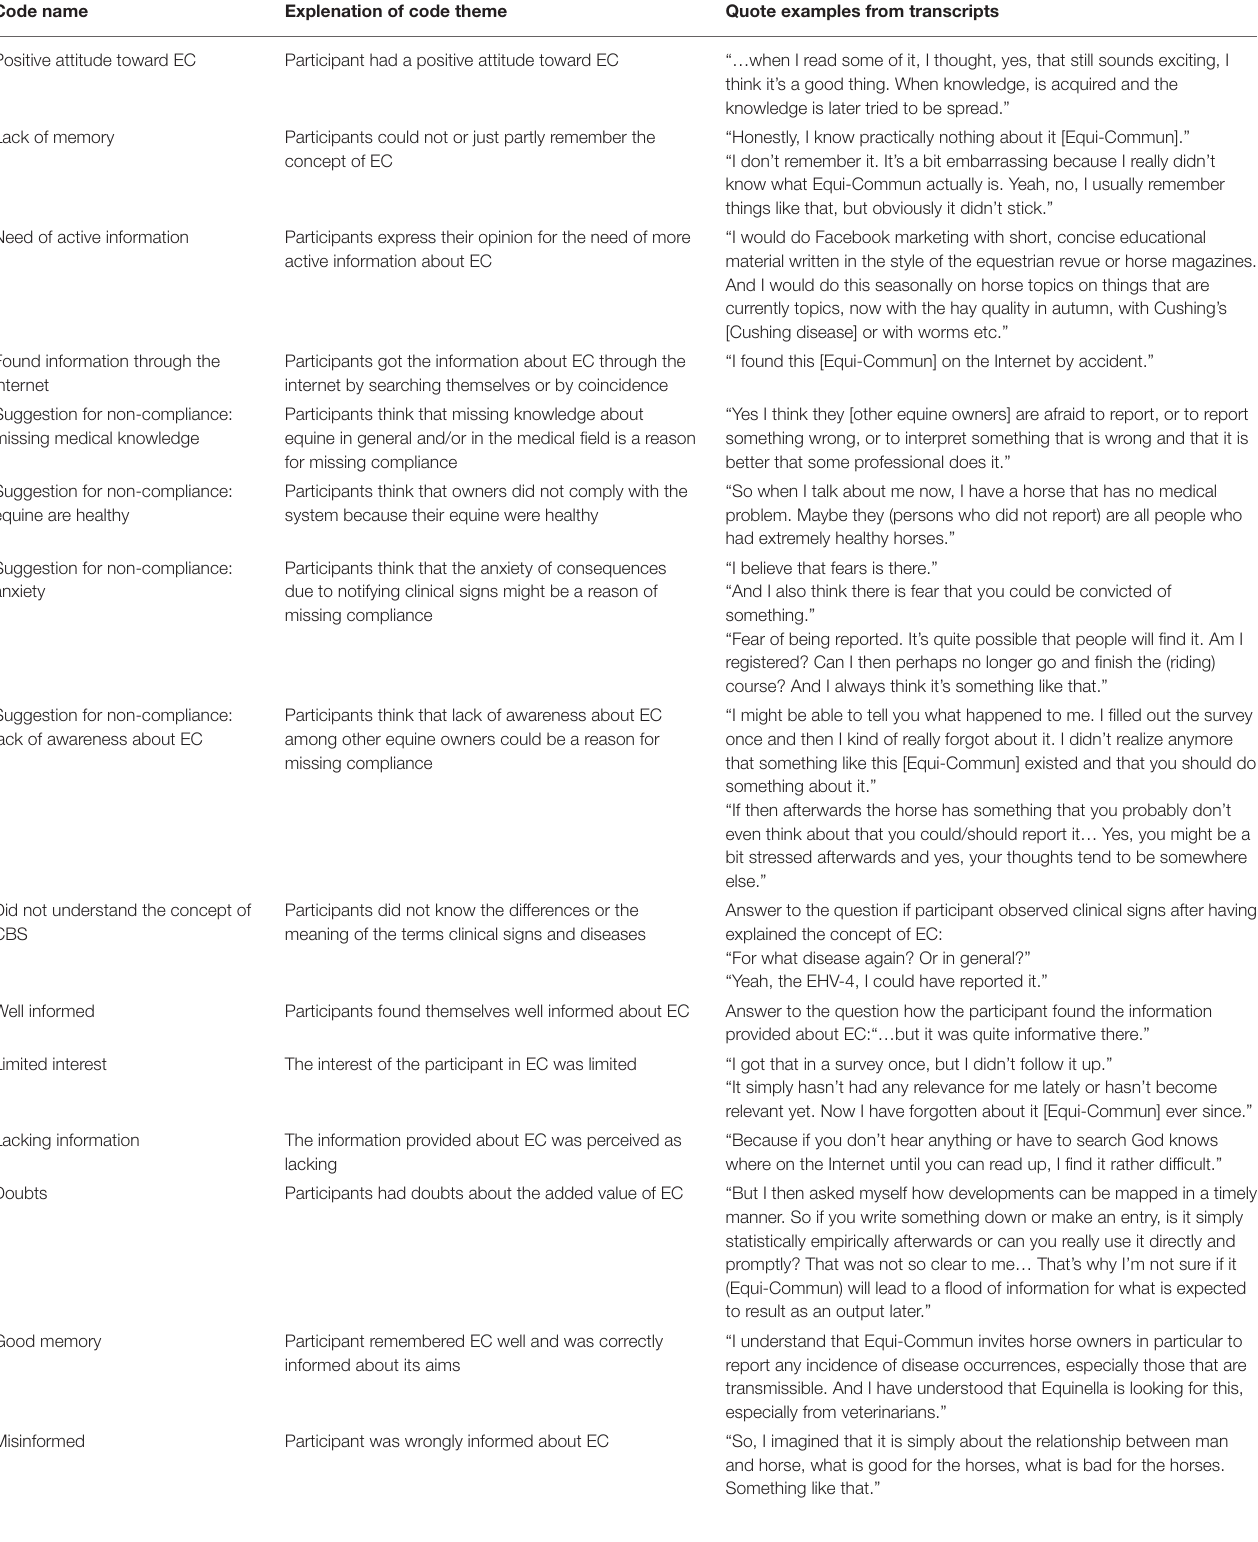
TABLE 4 | Codes created by intuitive coding using MAXQDA2020 Analytics Pro based on transcripts of semi-structured qualitative interviews among 10 equine owners regarding their perception of Equi-Commun (EC), definition of codes, and an example quote from the